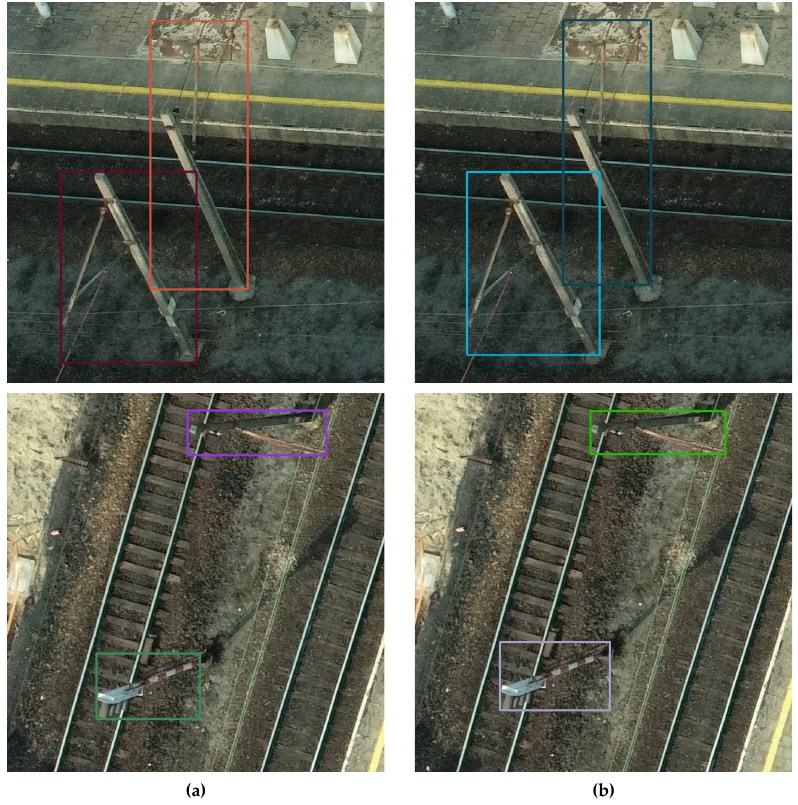
Figure 10. Example results for traction poles: ( a ) bounding boxes obtained from point cloud from DIM, ( b ) ground-truth bounding boxes obtained from point cloud from TLS.